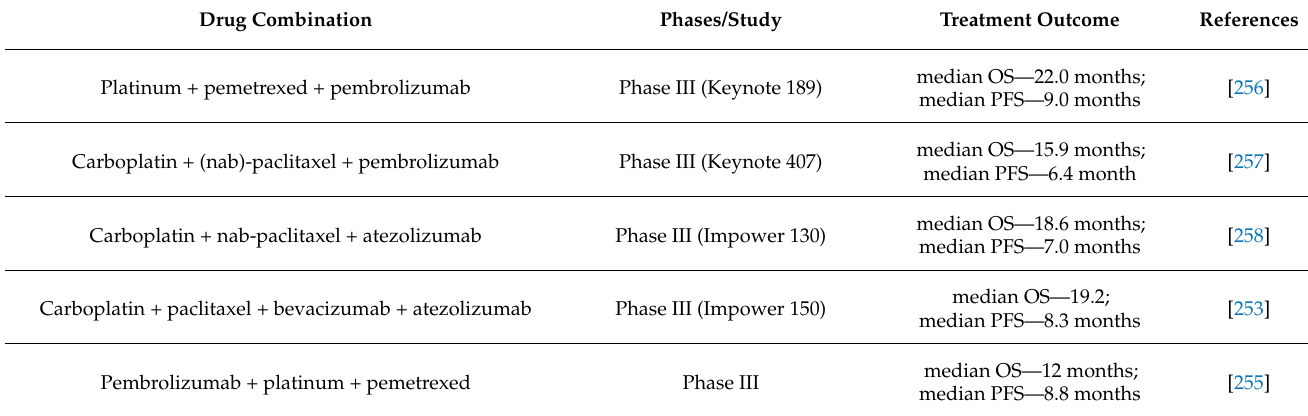
Table 3. An outline of clinical trials following combination approaches in lung cancer